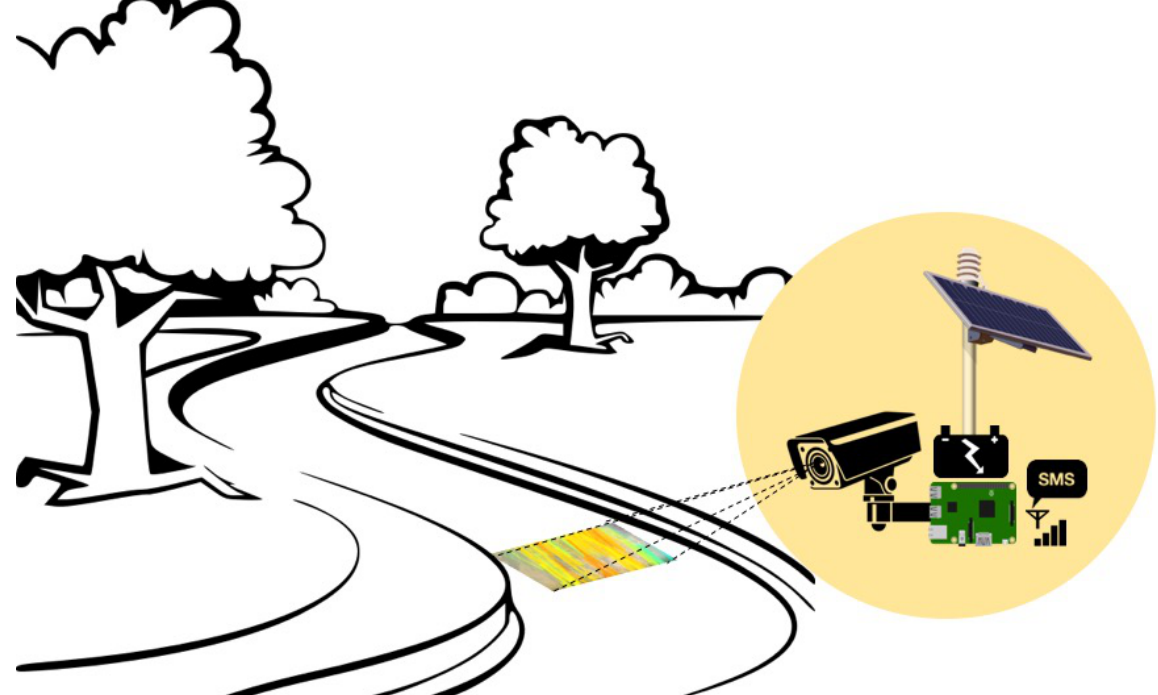
Figure 1. Sketch of the envisioned solar-powered measurement node made up of standard off-the-shelf devices placed in a remote monitoring site. The outcome computed in situ by the node is optionally sent to a centralized gathering system through standard text messaging such as a simple SMS requiring a shallow bandwidth communication